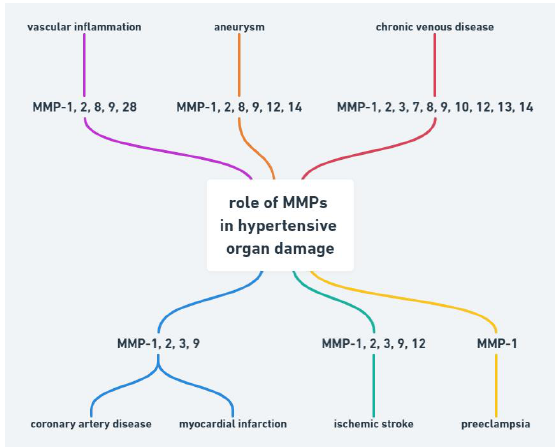
Figure 1. Role of MMPs in hypertensive organ damage.